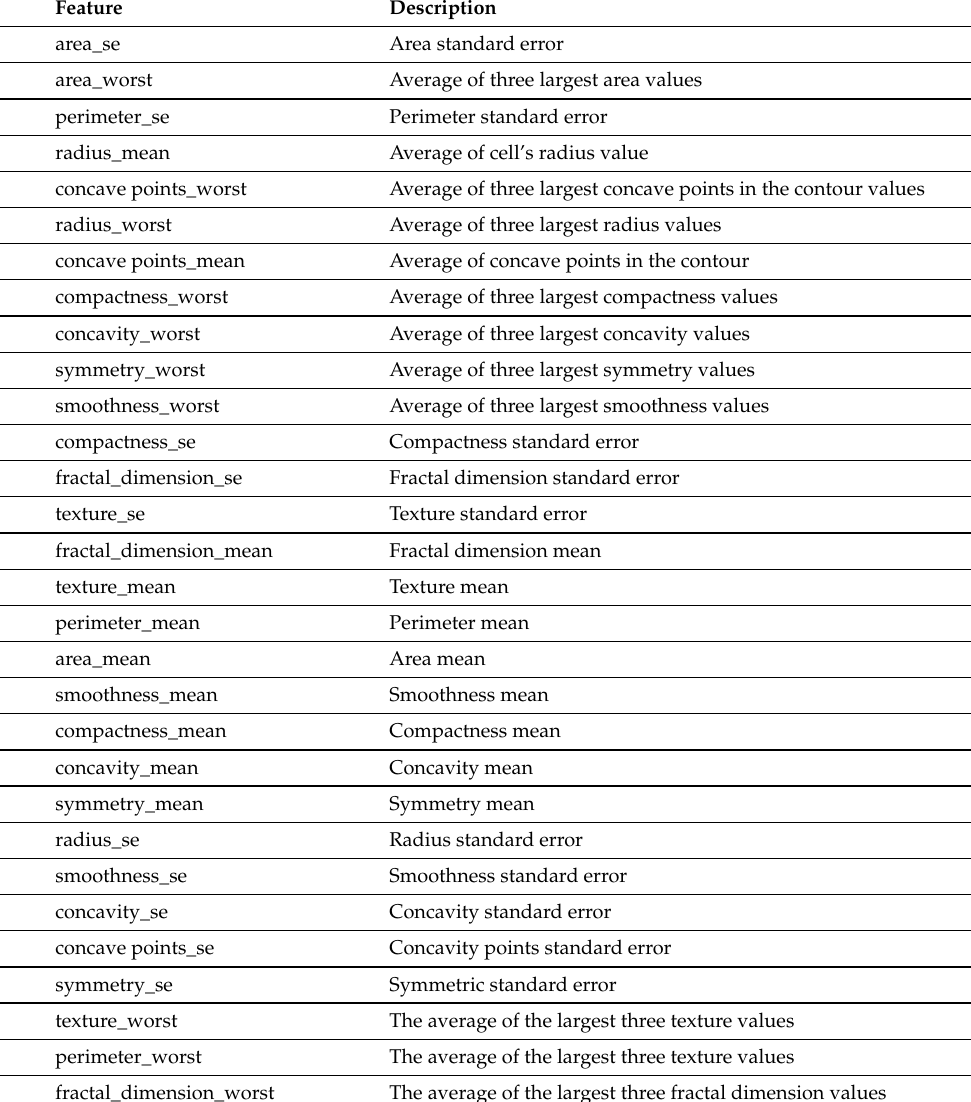
Table A1. Breast Cancer Wisconsin Diagnosis (BCWD) Dataset Feature description.